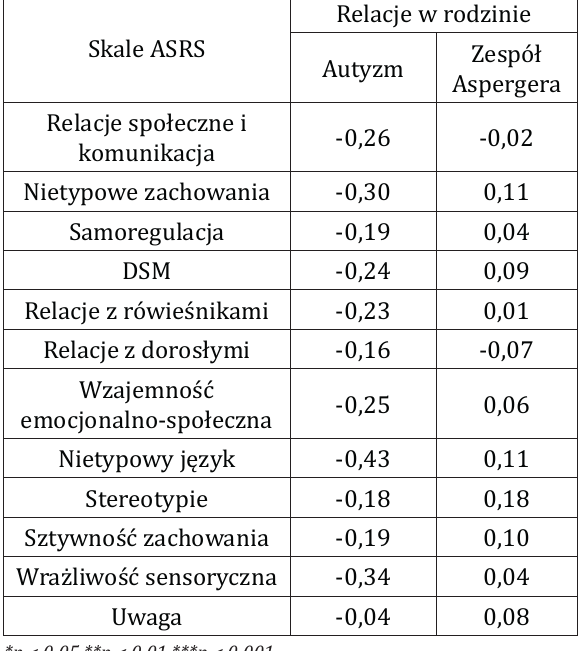
Tabela 2. Współczynniki korelacji obliczone między oceną relacji w rodzinie a skalami ASRS w grupie matek dzieci z autyzmem i